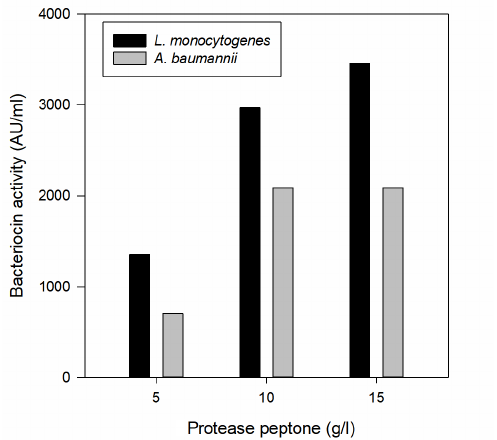
Fig. 5. Effect of protease peptone on bacteriocin production